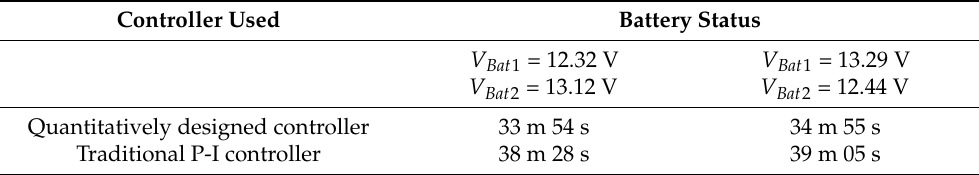
Figure 17. Equalizing discharge control response of the quantitatively designed controller when V Bat1 = 12.32 V and V Bat2 = 13.12 V: ( a ) initiate equalizing discharge control; ( b ) reach equalizing discharge equalization. Table 4. Comparison of equalizing discharge time between the quantitatively designed controller and traditional P-I